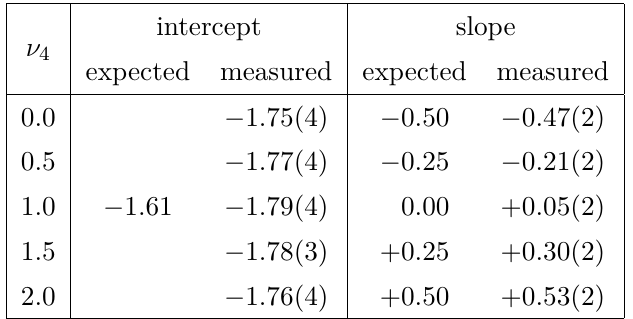
c 4 = 0 . 01 , ν 2 = 1 and various ν 4 . Differences e